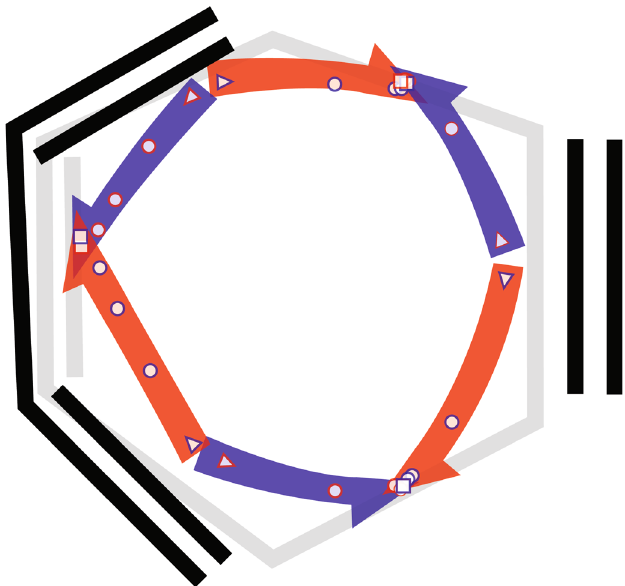
Fig. 7 The calculated curly arrow mechanism of the Diels – Alder reaction of 1,3-butadiene and ethylene. The apparently distorted geometries arises from the 3-dimensional reactant (black) and product (grey) geometries being projected onto the plane. The curved paths of the electrons are drawn through the calculated intermediate structures (start: triangle, end: